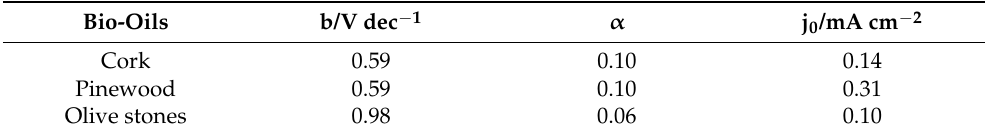
Table 5. Tafel slope, b, charge transfer coefficient, α , and exchange current density, j 0 , parameters obtained from Tafel analysis for each bio-oil sample with 3 M H 2 SO 4 .